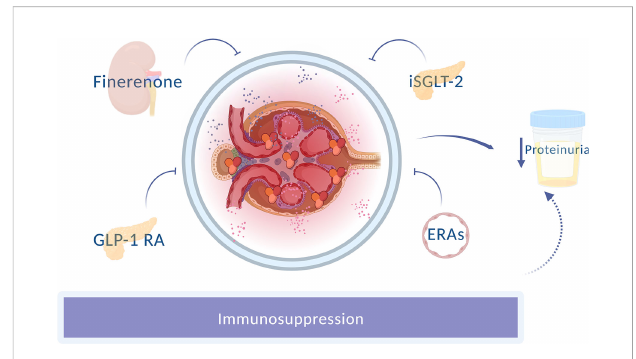
FIGURE 1 Novel nephron-protective strategies in lupus nephritis. Different drugs with an anti-proteinuric effect improve renal prognosis, apart from the usual immunosuppression. GLP-1RA, Glucagon-like peptide 1 receptor agonists; SGLT-2i, Sodium-glucose cotransporter-2 inhibitor; ERAs, Endothelin receptor